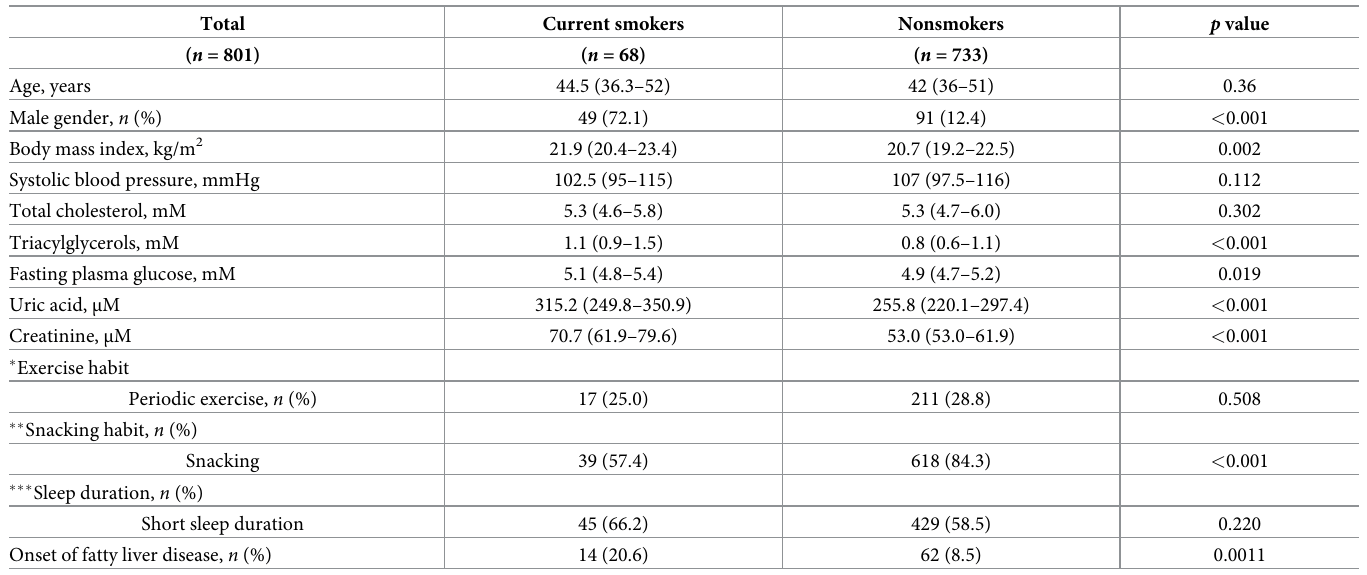
Table 1. Baseline characteristics of and the fatty liver disease incidence rate in the